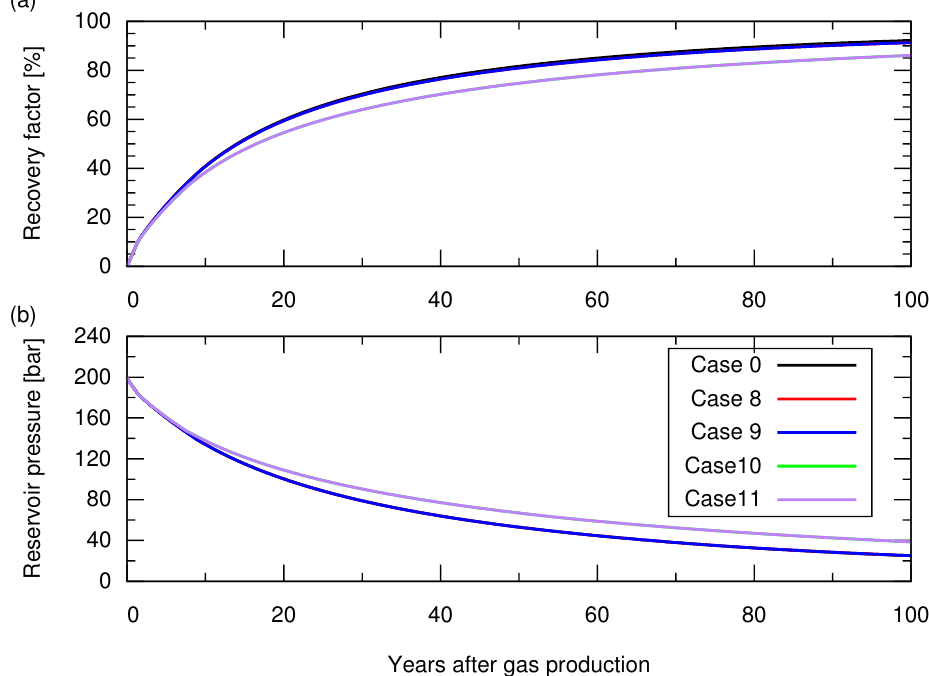
Figure 10. Results of the natural depletion simulations for cases 0 and 8 to 11. The descriptions of these cases are shown in Table 3. ( a ) Hydrocarbon gas recovery factor; ( b ) Reservoir pressure. Here, cases 8 and 9 resulted in profiles similar to that of case 0, while cases 10 and 11 resulted in the same